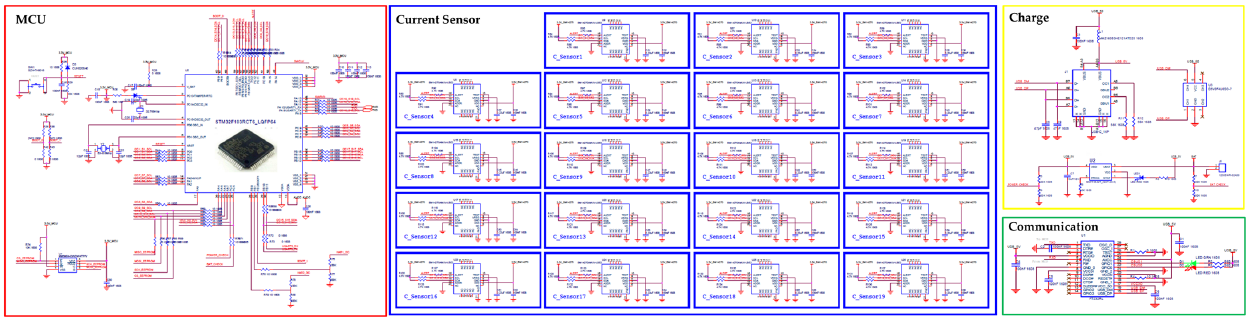
Figure 3. Circuit diagram of IEMS and peripheral circuit.